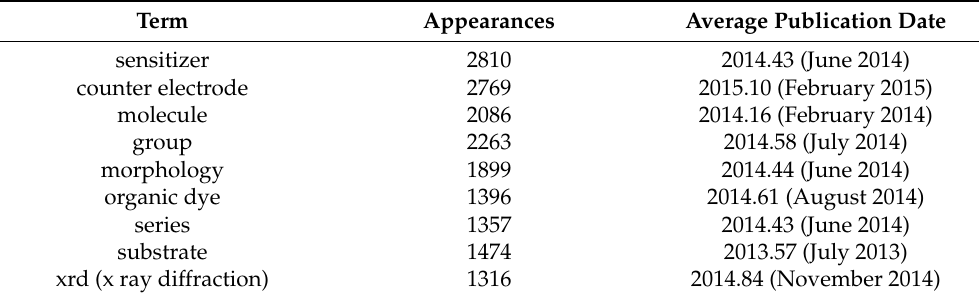
Table 1. Important Terms, total appearances and average publication date.